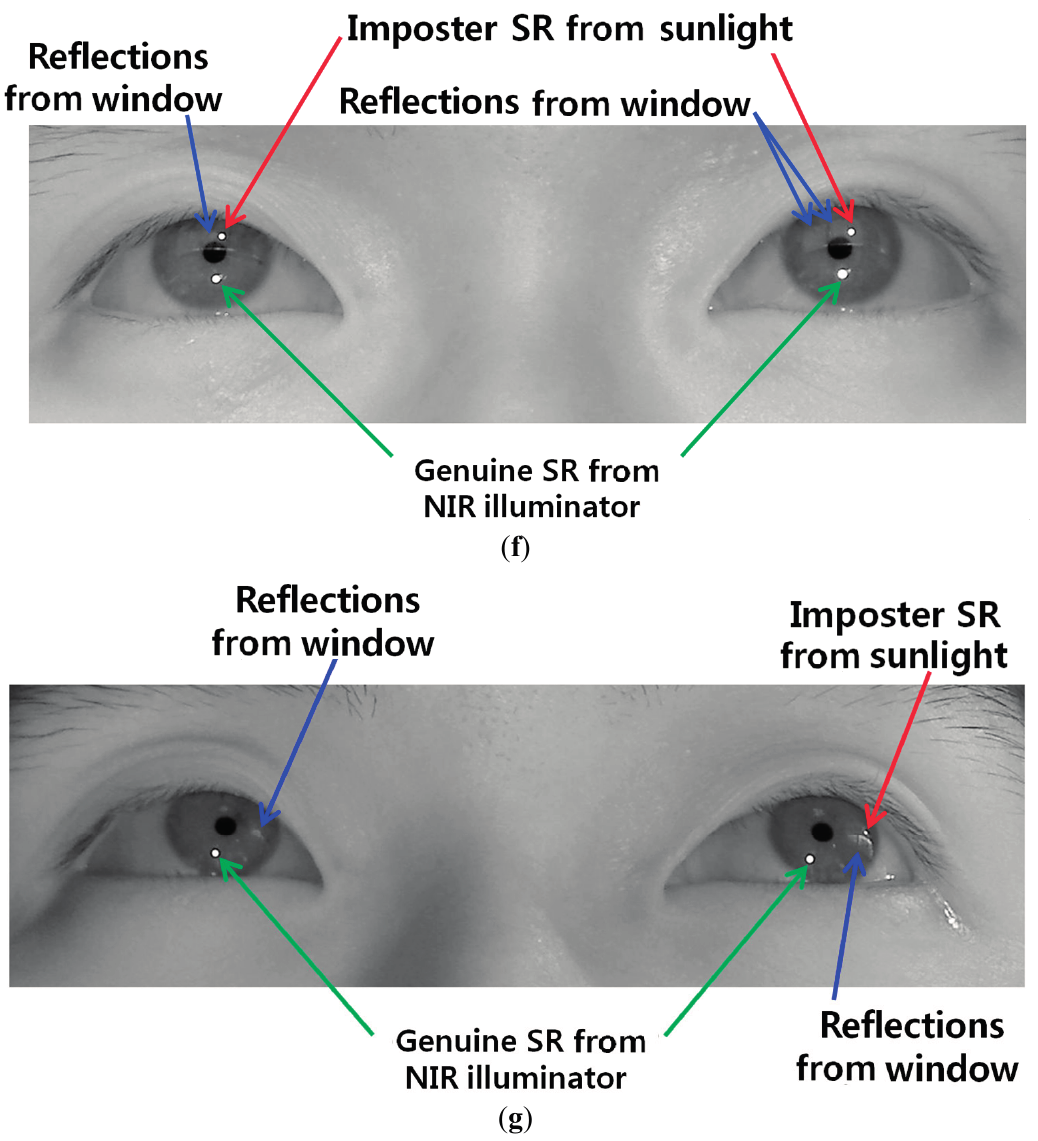
Figure 27. Comparative experiments in various positions of sunlight relative to user’s face. ( a ) the left, middle, and right images show the cases when sunlight is positioned in the left side, front, and right side of user’s face, respectively; ( b ) the captured eye image of the case of left image of (a) with BPF; ( c ) the captured eye image of the case of middle image of (a) with BPF; ( d ) the captured eye image of the case of right image of (a) with BPF; ( e ) the captured eye image of the case of left image of (a) with LPF; ( f ) the captured eye image of the case of middle image of (a) with LPF; ( g ) the captured eye image of the case of right image of (a) with